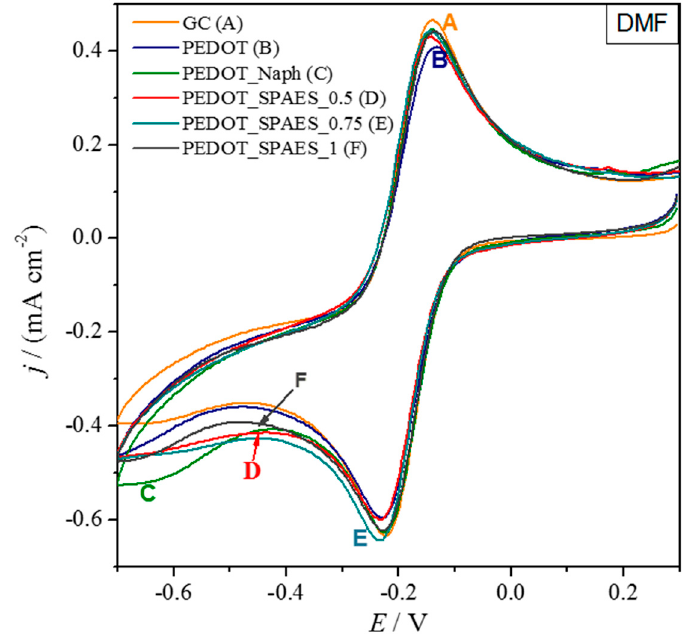
Figure 7. Cyclic voltammograms of bare glassy carbon (GC) and modified GC with polymers dissolved in DMF (Table A1). The electrochemical probe is 3 mM [Ru(NH 3 ) 6 ]Cl 3 .